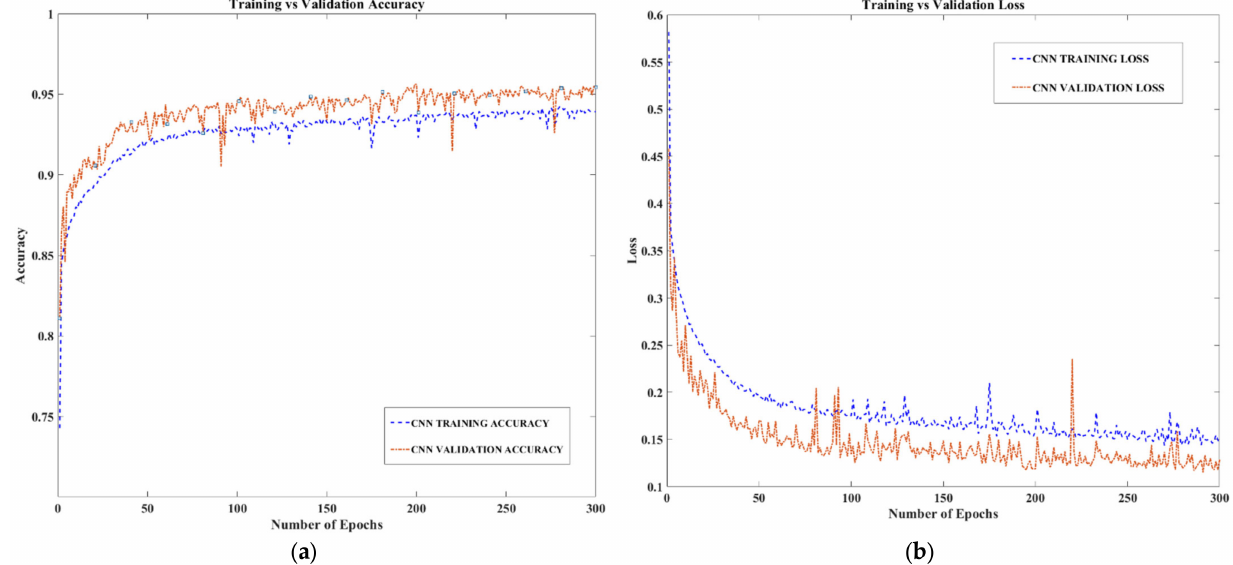
Figure 7. ViT model training and validation (45K pavement images): ( a ) accuracy graph; ( b ) loss graph. Owing to its slow initial convergence, the ViT classifier requires a large number of iterations before producing reliable results. Figure 8 depicts the ViT model’s receiver- operating-characteristic (ROC) curve. Based on the ROC curve, sensitivity (or true positive rate) and specificity (1-false positive rate) are weighed against each other. Almost reaching the upper left-hand corner of the diagram, the obtained curve is good for the model, as it indicates better performance. The proposed model’s false positive rate is 0.03 and its area under the ROC curve (AUC) is 0.97. This suggests that the algorithm can distinguish samples with cracks from those without, with an accuracy of 97%.